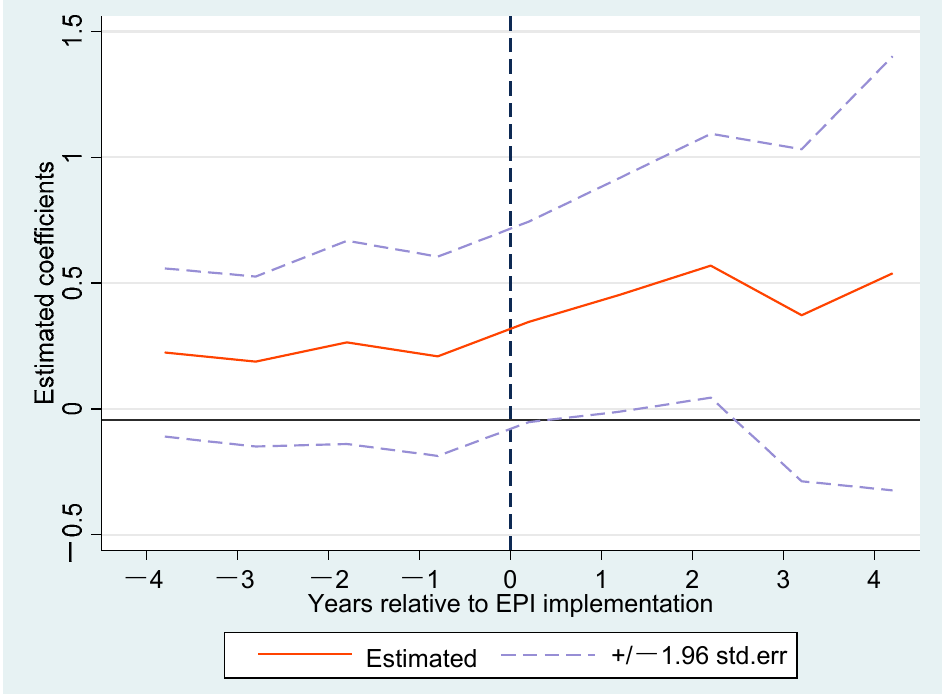
Figure 3. Common trend test.